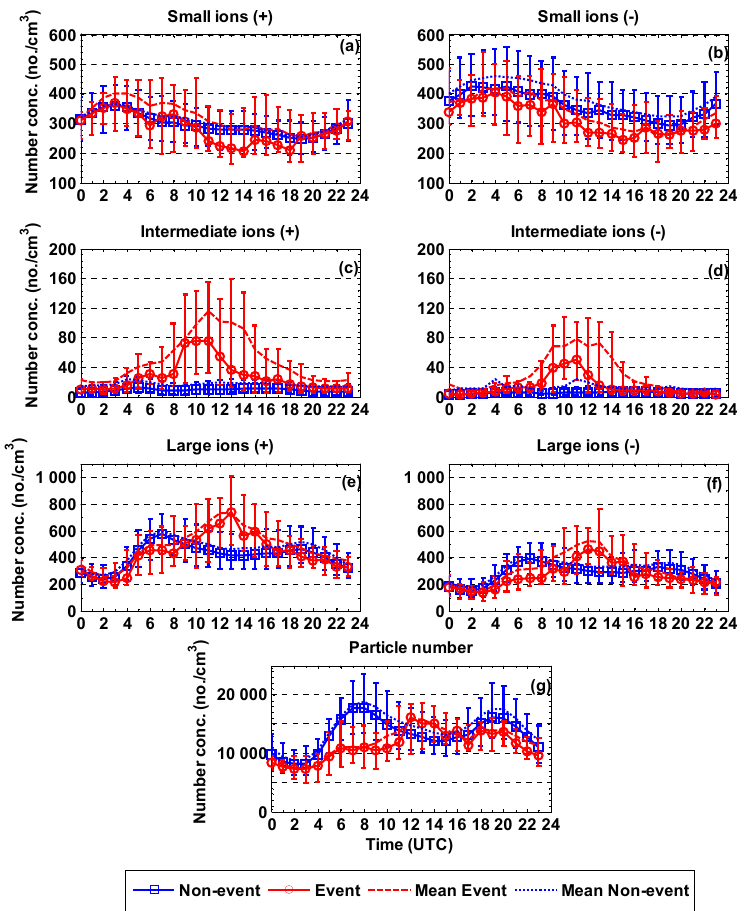
Figure 5. Diurnal cycle of aerosol particles and ions (small: 0.8–2nm; intermediate: 2–7nm; large: 7–20nm) on strong NPF event days and NPF non-event days. The markers show the hourly median number concentrations and the whiskers show 25th and 75th percentiles (1h data